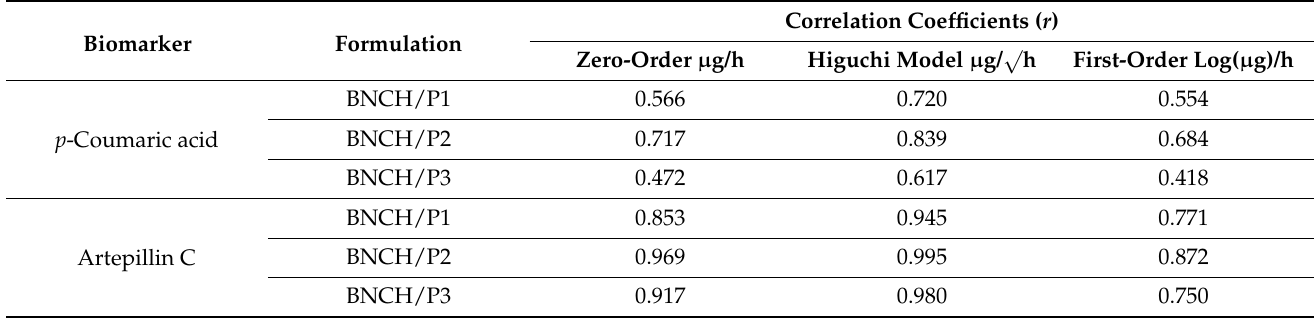
Table 2. Correlation coefficients ( r ) of the linear fraction of the biomarker release